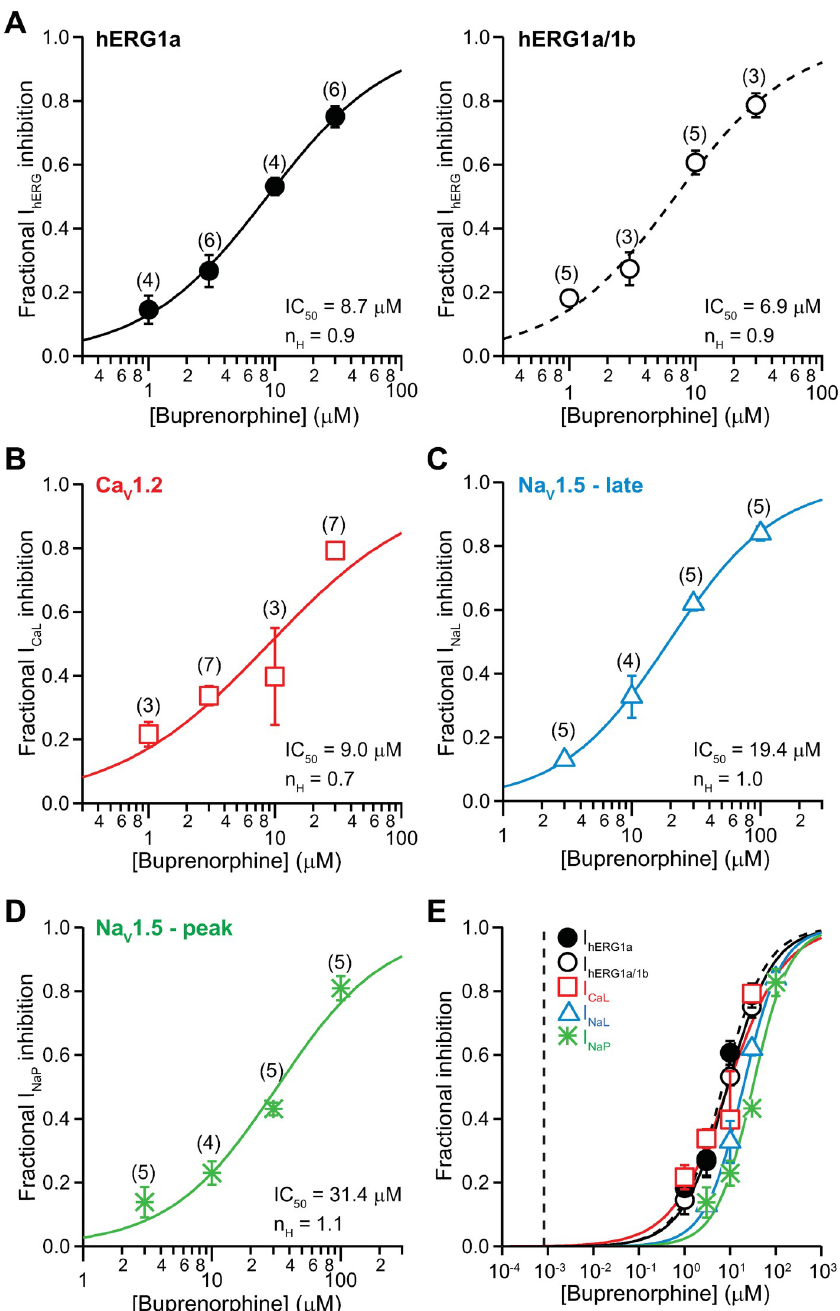
Fig 3. Effects of buprenorphine. Concentration-inhibition plots of buprenorphine on I hERG (A) , I CaL (B) , I NaL (C) , and I NaP (D) . Data are shown as mean ± SEM. Each plot was fit with the Hill equation to the mean values, with maximum and minimum constrained to 1 and 0, respectively. The numbers in the parentheses correspond to the number of data points obtained for each drug concentration. E) An overlay of concentration-inhibition plots of buprenorphine on all tested ionic currents. The vertical dashed line indicates free C max of 0.00087 μ M.